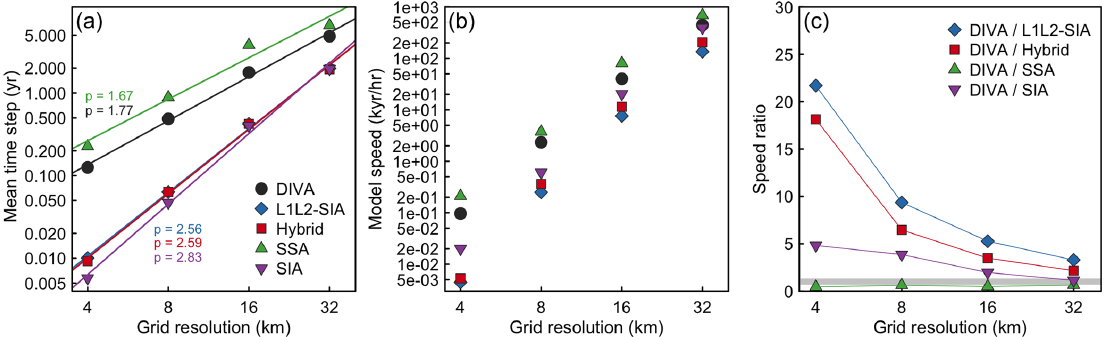
Figure 3. (a) Mean model time step, (b) mean model speed (kiloyears model time per hour of computation on one processor) and (c) ratio of the DIVA mean model speed relative to other solvers (a ratio of > 1 implies the simulation using the DIVA solver ran faster) versus grid resolution.